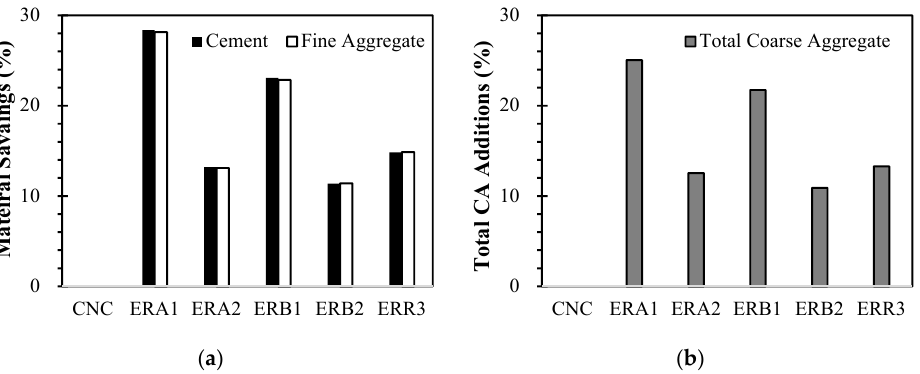
Figure 3. Material quantity change: ( a ) savings in cement and fine aggregate and ( b ) additions in total coarse aggregate.